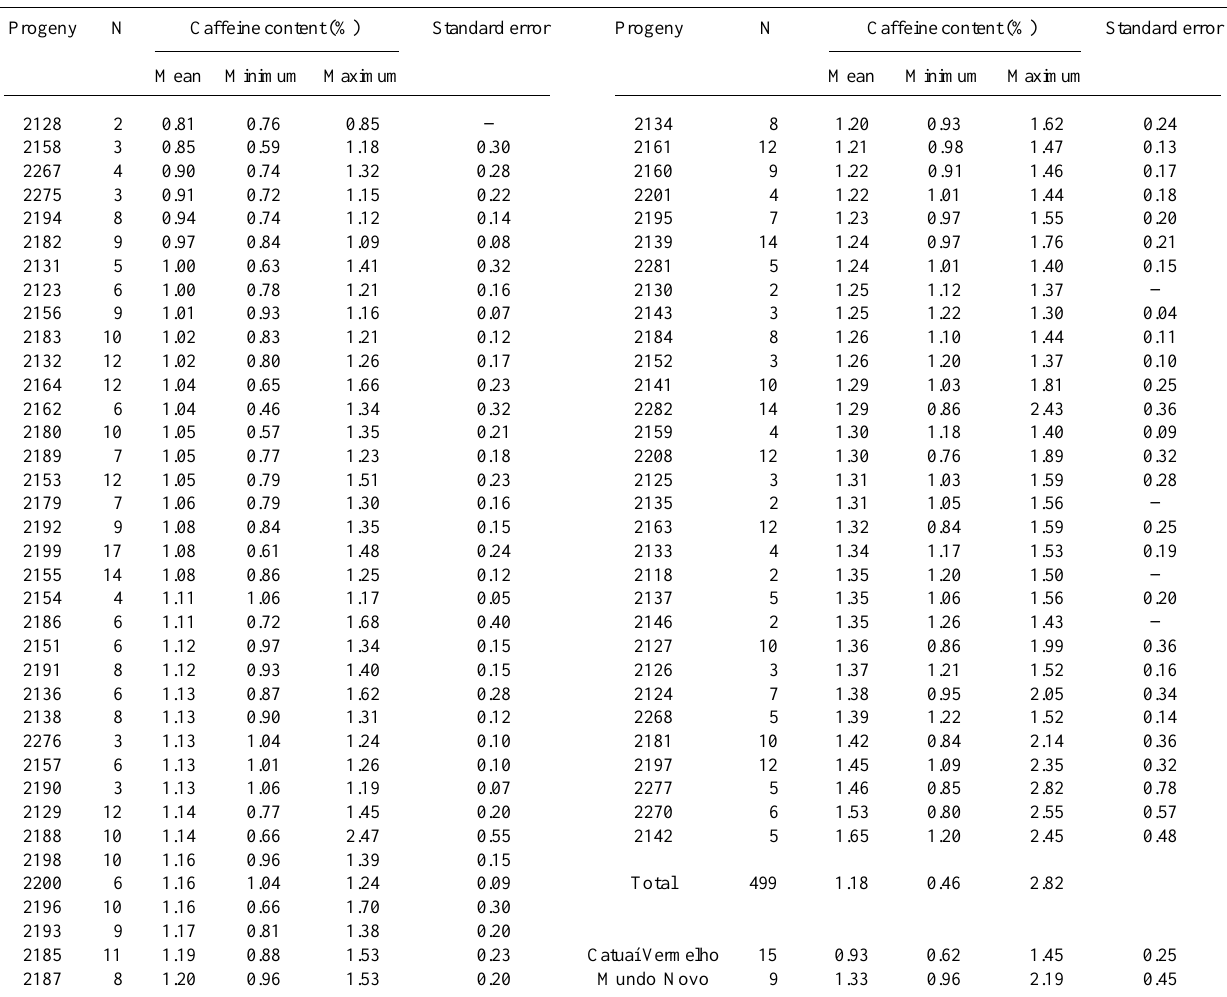
Table I - Caffeine content (%) of beans from 68 Coffea arabica progenies from the Kaffa region of Ethiopia, compared with two Brazilian cultivars (Catuaí Vermelho and Mundo Novo).